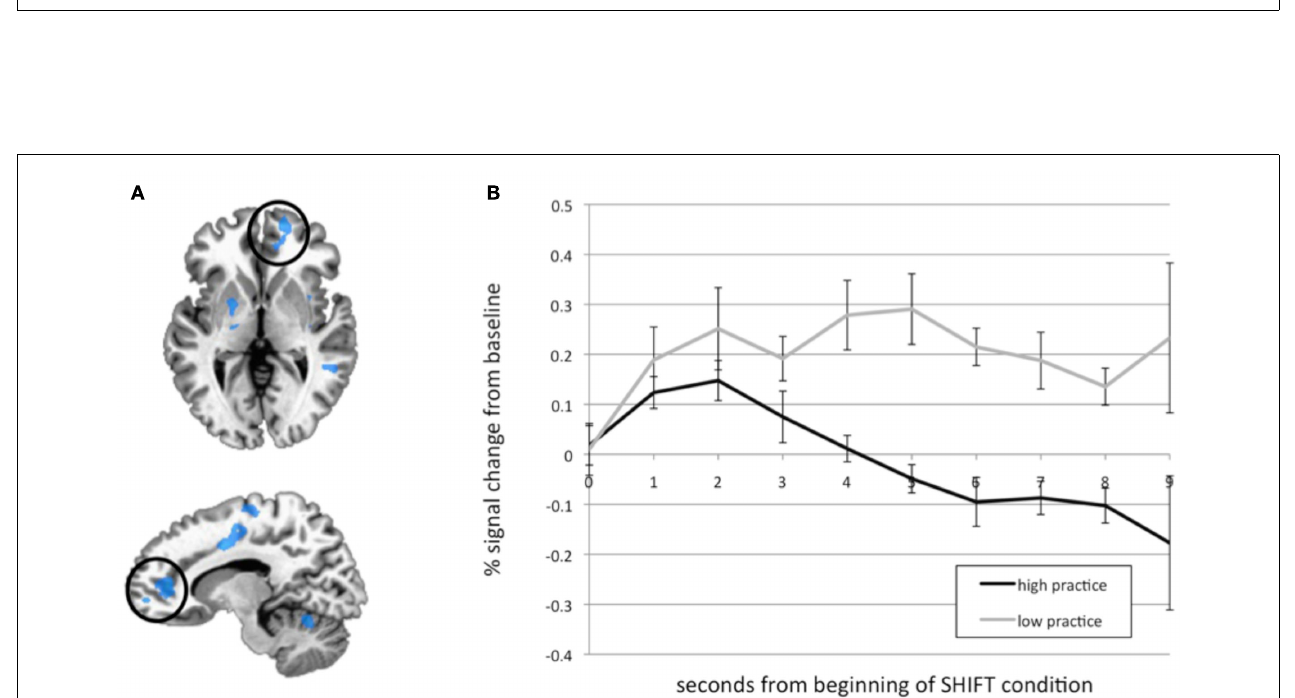
FIGUREA3 | Bimodal distribution of practice time. Each subject’s estimated lifetime practice hours is plotted against his/her age.This subject population naturally fell into a bimodal distribution, with five participants